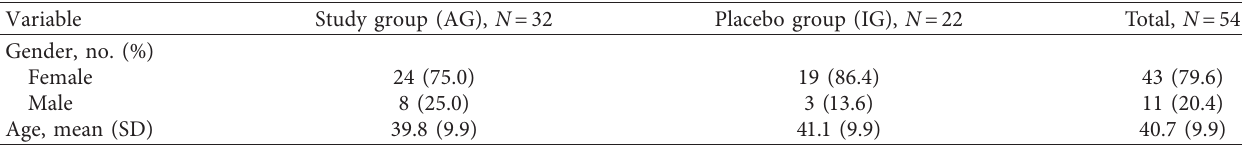
Figure 3: NOVAFON Pro Sk2/2 (a); application points used at the (b) temporomandibular joint; (c) masseter muscle and temporalis muscle. Table 1: Characteristics of the study